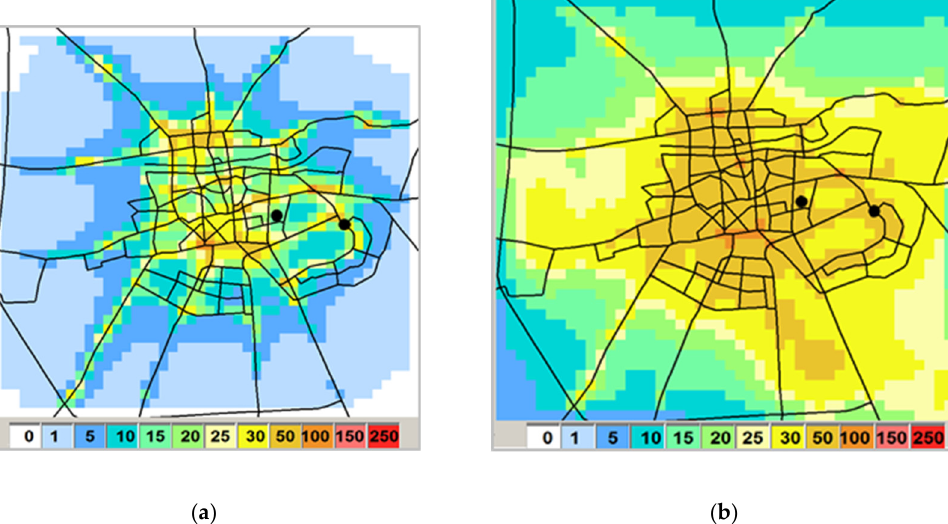
Figure 12. Monthly mean PM 10 concentrations ( µ gm − 3 ) for the city of Plovdiv simulated by LAQMS from all sources in the city and background concentrations from BgCWFS_sat: ( a ) August 2017; ( b ) February 2019. The black dots indicate the two AQ stations.